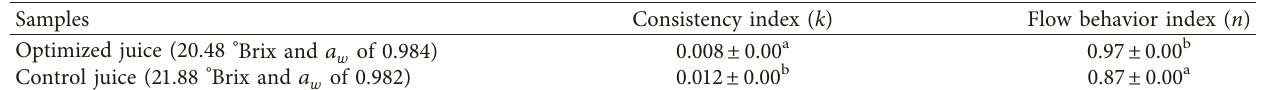
Table 7: Consistency index ( k ) and flow behavior index ( n ) of optimized juice and control juice.